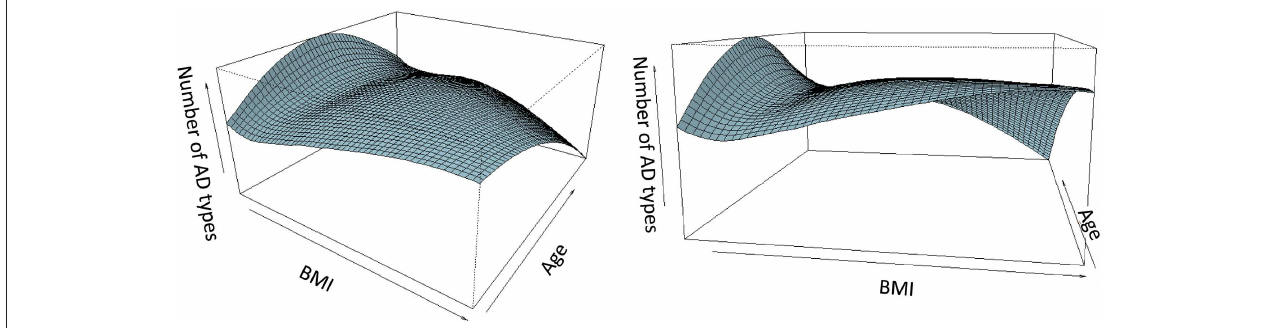
FIGURE 5 | Number of different AD types prescribed to a patient, in relation to BMI and age. AD, antidepressant medications; BMI, body mass index. Two different views (at different angles) of the same smooth surface plot are presented. The plot represents relationships between the number of different AD types prescribed to a patient, patient’s BMI, and patient’s age. Each horizontal line represents an age group. For young patients, the number of different AD increases with increasing BMI. For middle aged patients, the relationship is close to U-shaped. For old patients, the number of AD types prescribed decreases with an increase in